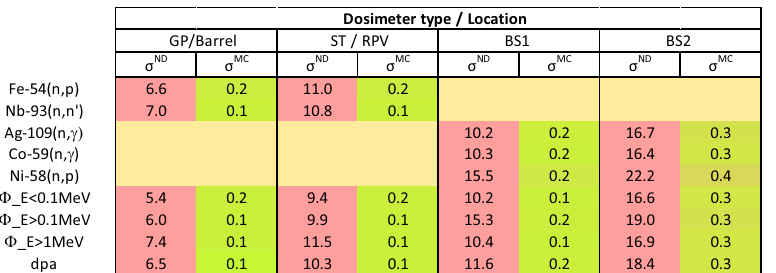
Table I. ND-related calculation uncertainties and corresponding MCNP relative errors ( (cid:4) MC , %) .